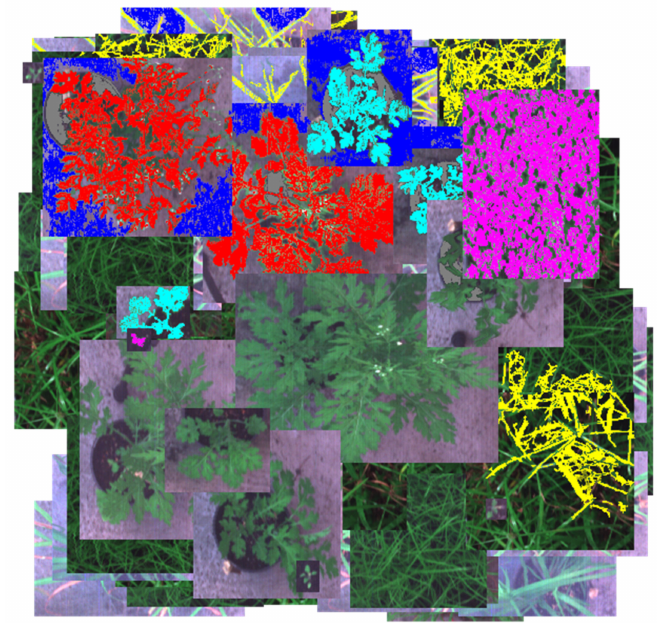
Figure 8. Combined hypercube with label